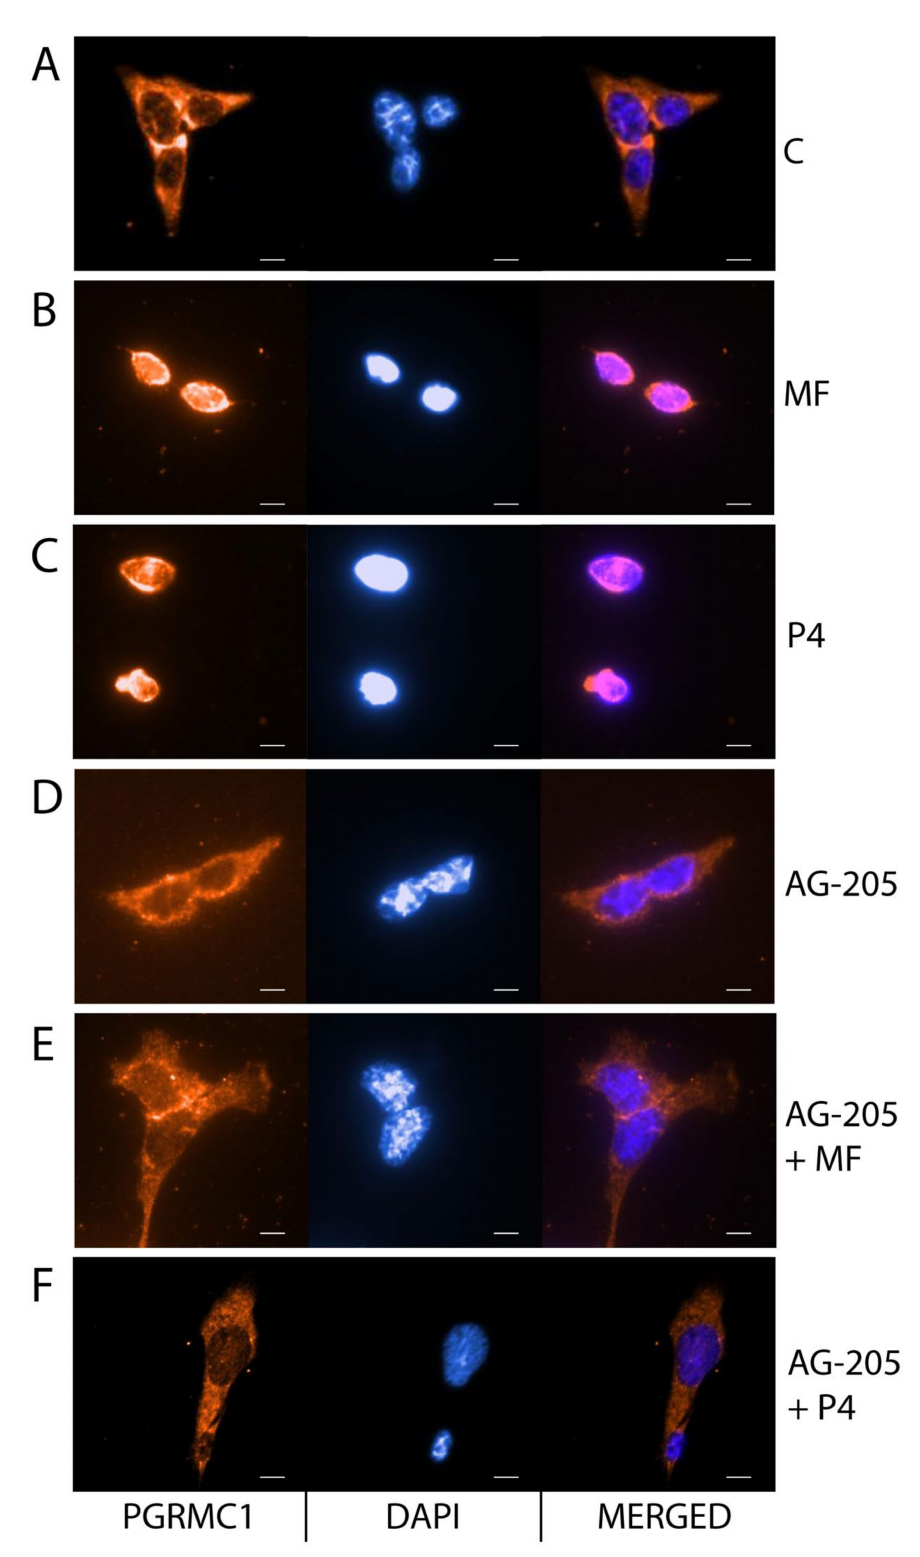
Figure 5. MF and P4 treatments e ff ects on the nuclear translocation of PGRMC1 in BLTK-1 cells. Immunocytochemical localization of PGRMC1 without C ( A ) or with MF ( B ), P4 ( C ), AG-205 ( D ), AG-205 + MF ( E ) and AG-205 + P4 ( F ) in BLTK-1 cells. Scale bar, 20 µ m. AG-205, PGRMC1 inhibitor; C, control; MF, mifepristone; P4,